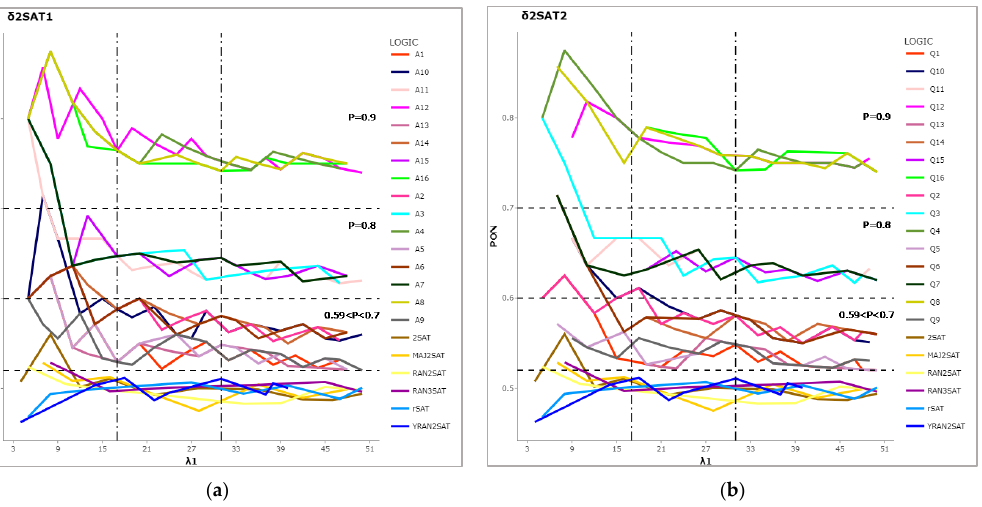
Figure 4. PON line representation for models in both types of logic ( a ) 1 2 SAT 